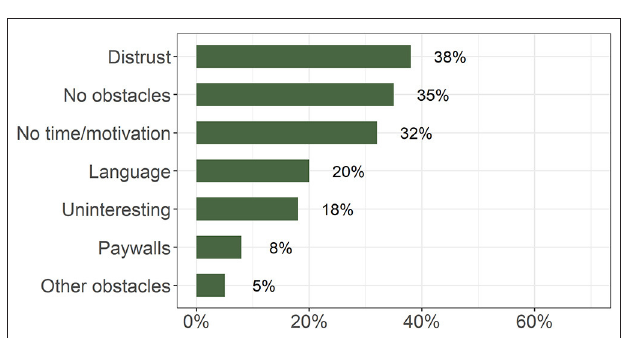
FIGURE 6 | Percentage of responses to the question “Have you encountered any obstacles in searching for information about the brain?” ( n = 887; multiple answers